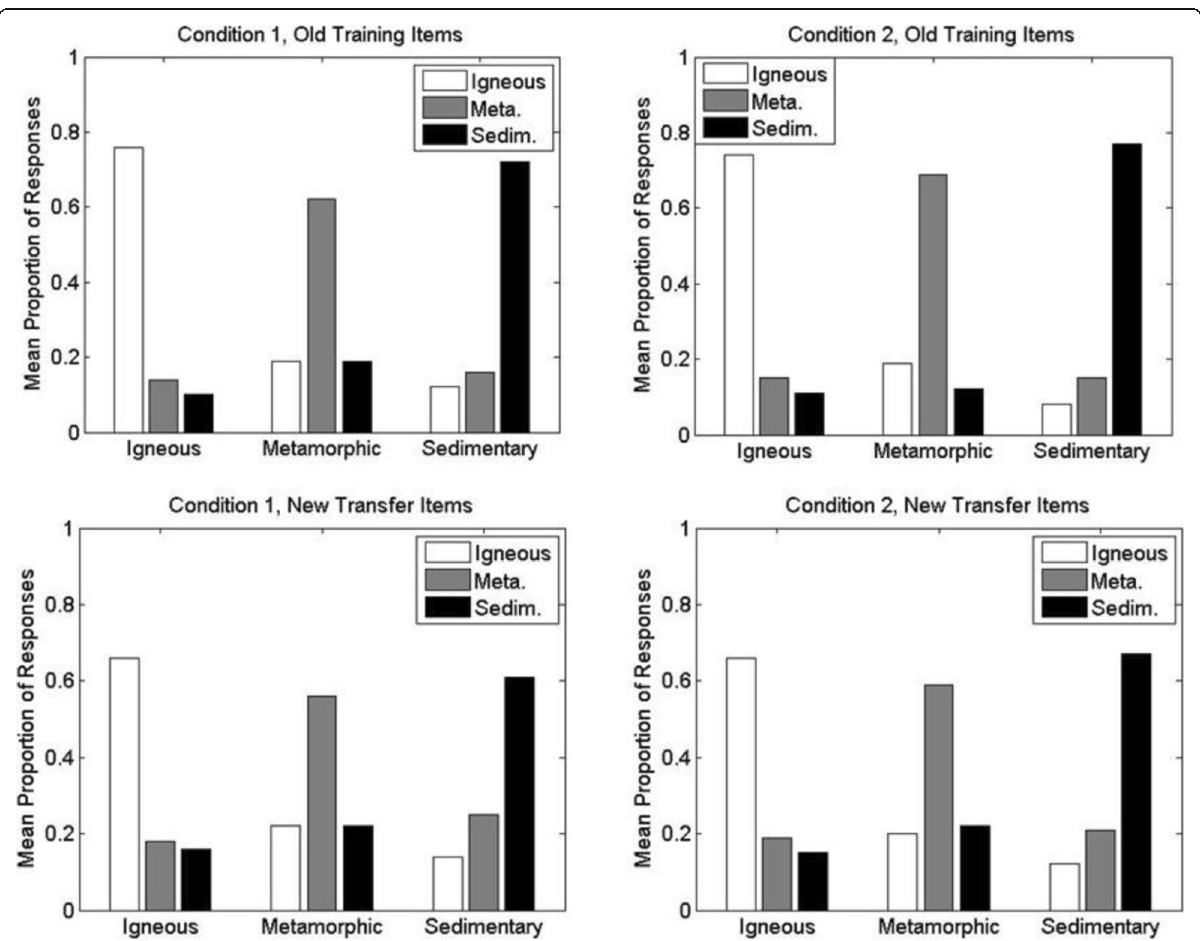
Fig. 7 Experiment 1A: mean proportion with which members of each high-level category were classified into the alternative high-level categories during the classification test phase of conditions 1 and 2. (Left panels) Condition 1; (right panels) condition 2; (upper panels) old training items; (lower panels) new transfer items. For example, within each panel, the white bar to the far left indicates the mean proportion with which members of the high-level igneous category were correctly classified as igneous, whereas the adjacent gray bar indicates the mean proportion with which members of the igneous category were incorrectly classified as metamorphic (Meta.). Sedim. show the results for the old training items whereas the bottom panels show the results for the new transfer items.